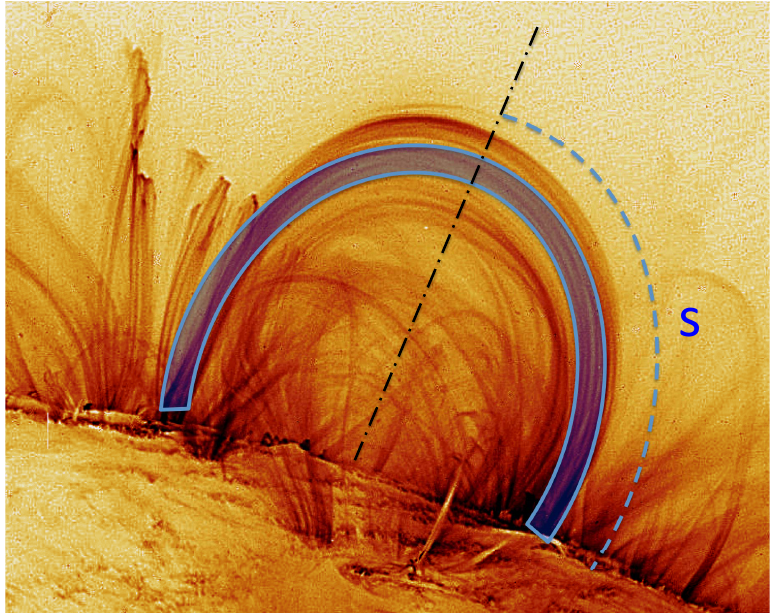
Figure 12: The plasma confined in a loop can be described with one-dimensional hydrodynamic modeling, with a single coordinate ( 𝑠 ) along the loop. Image: TRACE, 6 November 1999, 2